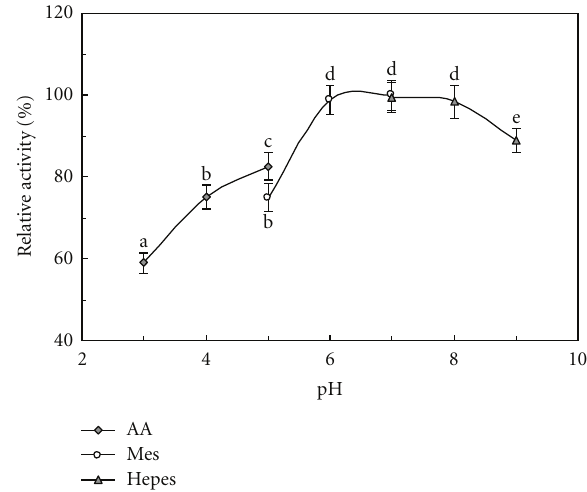
Figure 4: E ff ect of pH on activity of the purified protease. Results are presented as mean ± SD ( n = 3). Di ff erent letters (e.g., a, b, c, and d) next to the data points indicate statistically significant di ff erence ( P < 0 . 05) when the data are analyzed by analysis of variance followed by Duncan’s multiple range test.